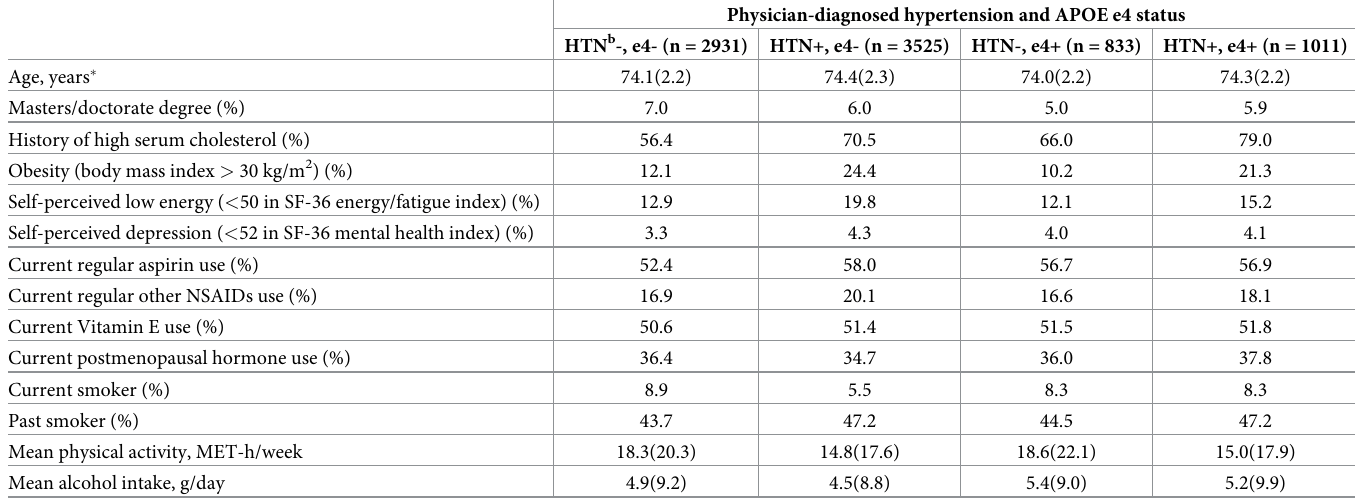
Table 1. Age-adjusted characteristics of women at baseline a according to physician-diagnosed hypertension and APOE e4 genotype status (n =